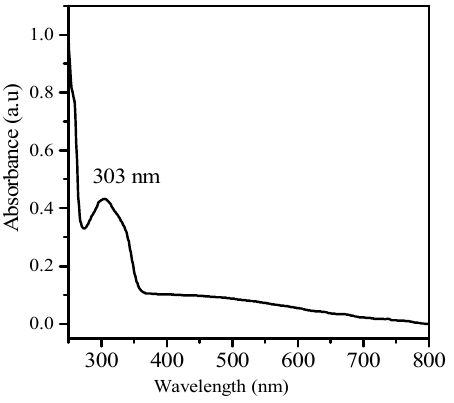
Figure 1. The UV spectrum of the silver nanoparticles derived from marine Streptomyces sp. Al-Dhabi-87. A high-resolution scanning electron microscope (HRSEM) image depicted that the synthesized NP diameter sizes were ranged from 20–50 nm (Figure 3). Also, it is interesting that the synthesized